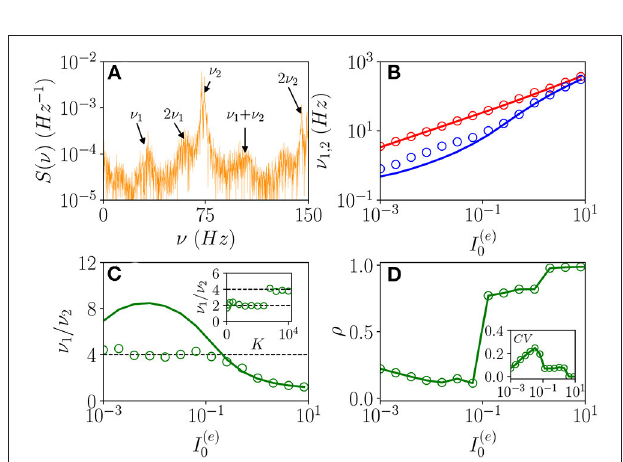
FIGURE 9 | From quasi-periodicity to frequency locking. (A) Power spectra S ( ν ) of the mean membrane potential obtained from network simulations. (B) The two fundamental frequencies ν 1 ( ν 2 ) vs. I ( e ) 0 . (C) Frequency ratio ν 1 /ν 2 vs. I ( e ) 0 , in the inset ν 1 /ν 2 is shown vs. K . (D) Coherence parameter ρ vs. I ( e ) 0 , in the inset the corresponding CV is reported. In (B,C) , the symbols (solid lines) refer to ν 1 and ν 2 as obtained from the peaks of the power spectra S ( ν ) for V ( t ) obtained from the network dynamics (to the two relaxation frequencies ν R 1 and ν R 2 associated to the stable focus solution for the MF). Parameters as in Figure 1 , other parameters are set as 1 ( ii ) 0 0.3, 1 ( ee ) 0 1.58, N ( e ) 80,000, = = = N ( i ) 20,000, K 8,192, and I ( e ) 0 0.128 in the inset of (C) . = = =